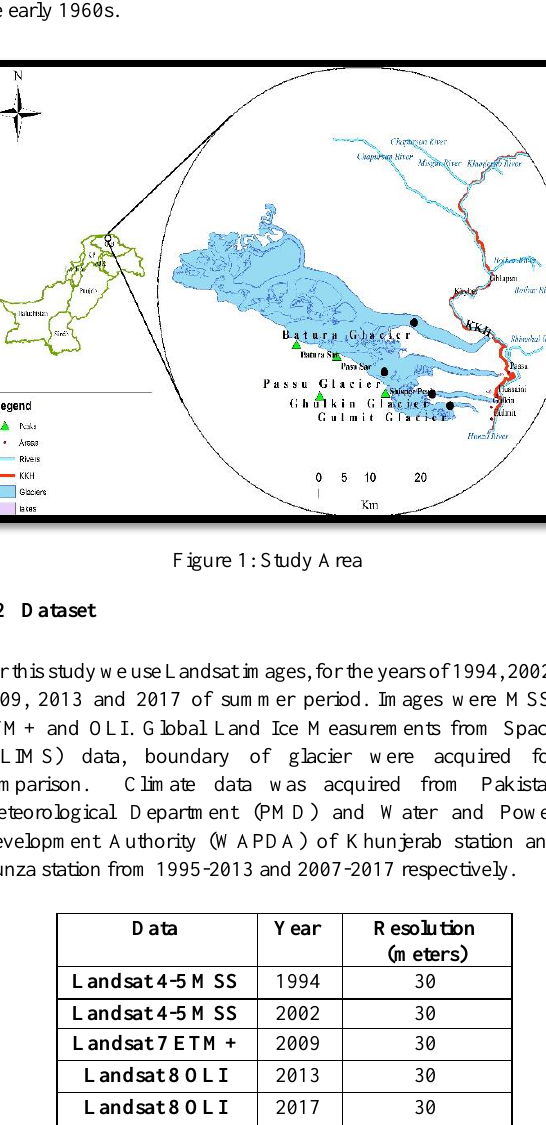
Table 1: Data acquisition of remotely sensed imagery